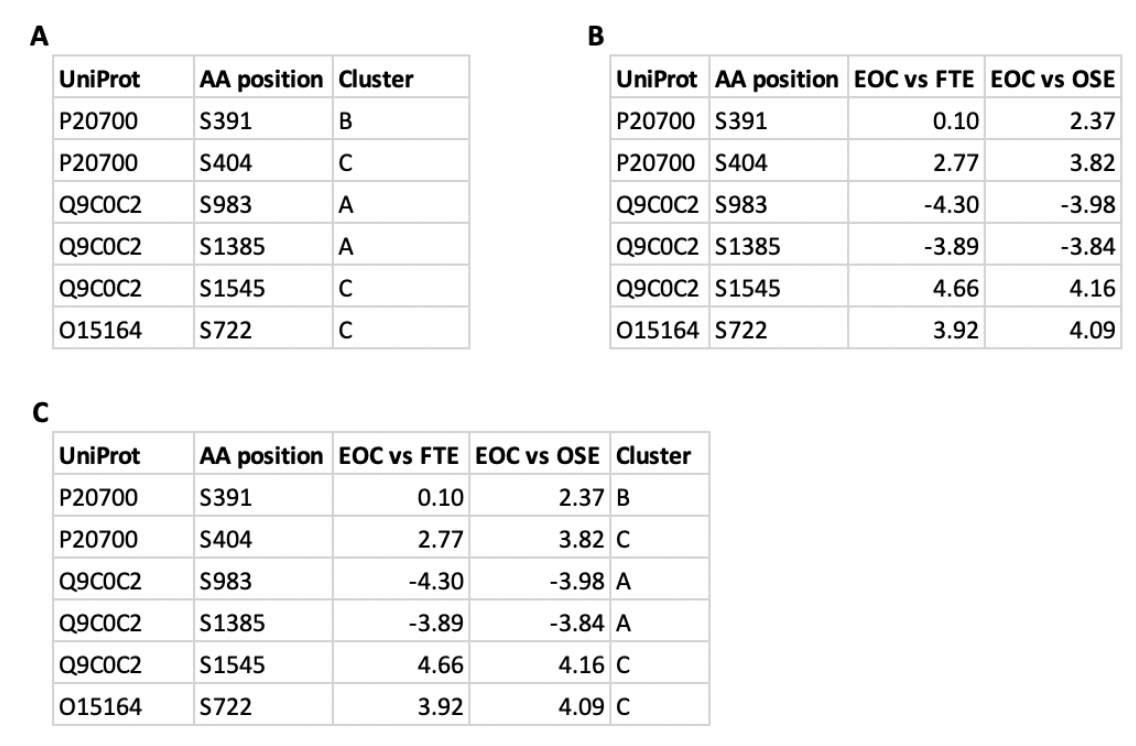
Figure 2. Desired formats for table import. This shows three examples of how tables can be formatted before being imported with Omics Visualizer. One column contains the node identifier (‘UniProt’), and the other columns contain the values to be visualized (‘Cluster’ with pie visualization, ‘EOC vs FTE’ and ‘EOC vs OSE’ with donut visualization). It is possible to format your table for pie visualization ( A ), donut visualization ( B ), or both ( C ). You can have some extra columns that will not be used to visualize but for other purposes, for example, here the column ‘AA position’ identifies the specific site of the protein and are used as